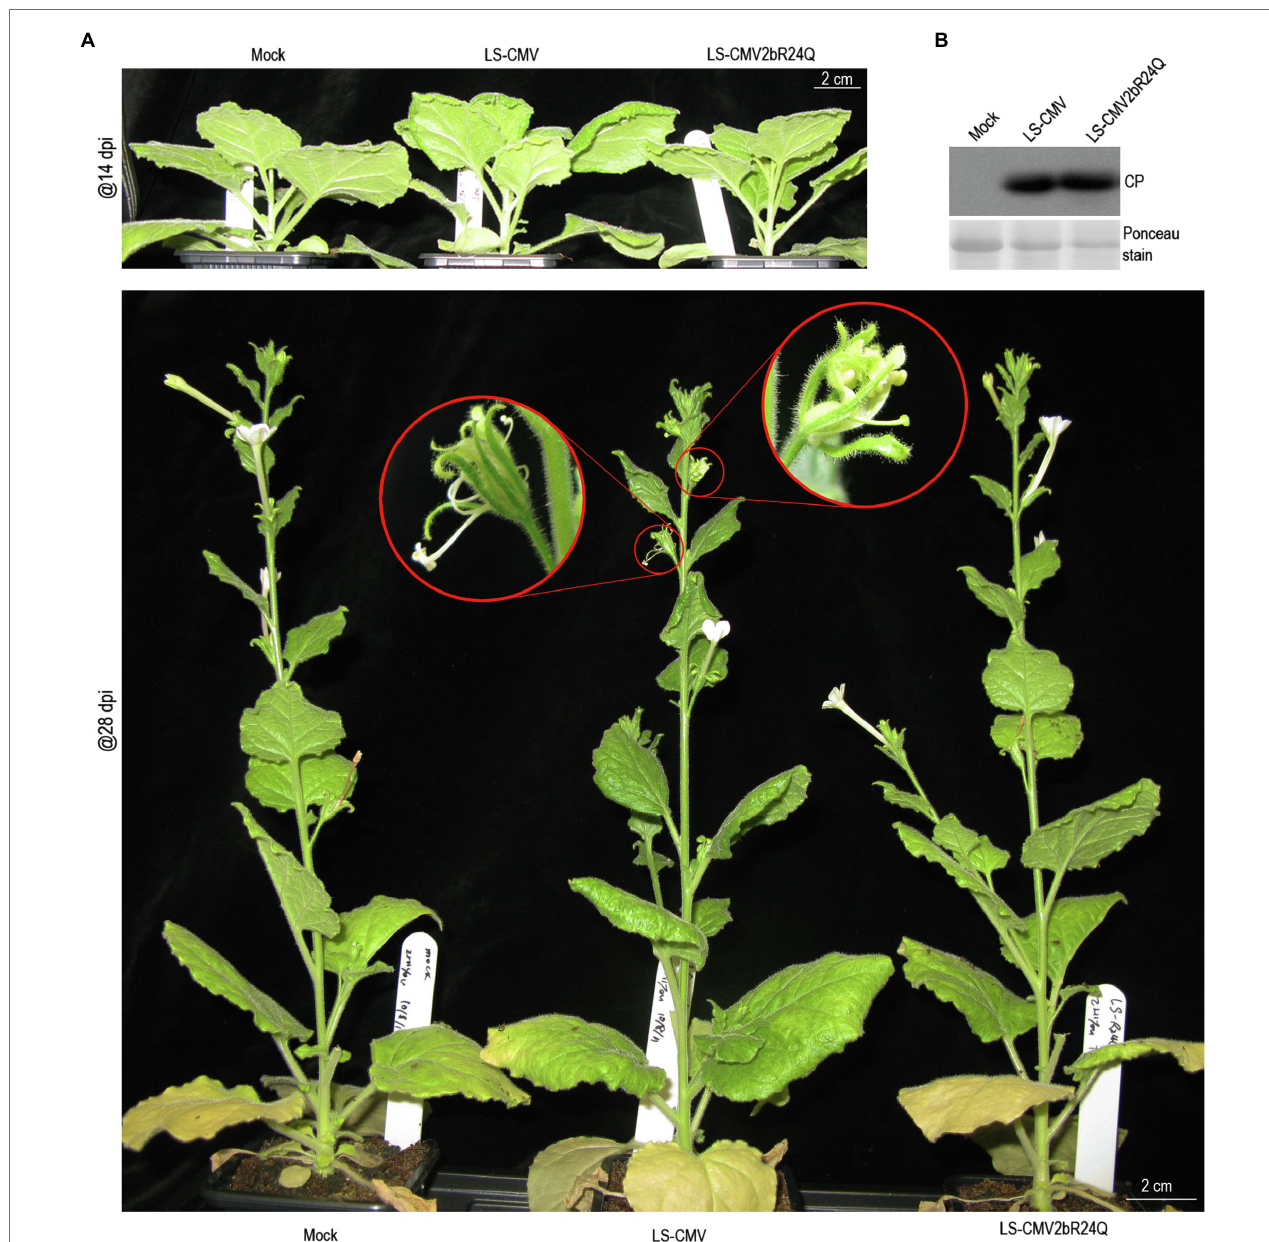
FIGURE 3 | Reducing nuclear accumulation of the LS2b protein compromised viral pathogenicity in plants. (A) Viral symptoms on N. benthamiana plants inoculated with LS-CMV or its mutant LS-CMV2bR24Q. Mock is the plants treated with distilled water. The inoculated plants were photographed at 14 (upper panel) or 28 (lower panel) days post-inoculation (dpi) as indicated. The phenotypically defective flowers were shown with a close-up view as indicated by red circles (lower panel). (B) Immunoblot analysis of the accumulation of LS-CMV CP in the upper systemic leaves as indicated. Ponceau S staining was used to show equal amount of the protein samples